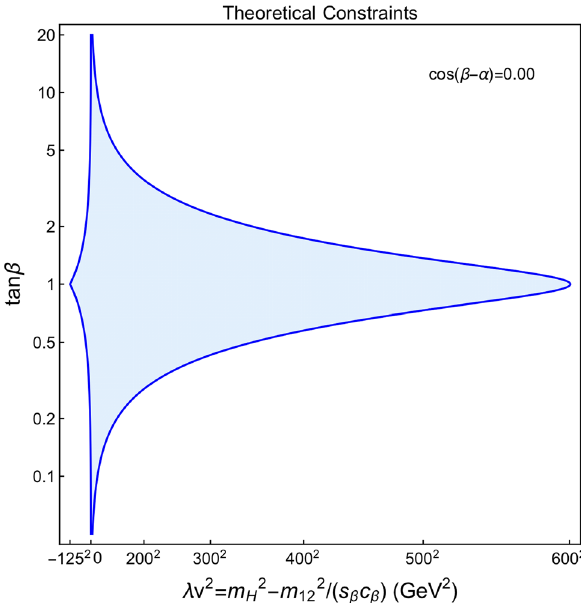
Fig. 1 Allowed regions by and theoretical constraints in the λv 2 -tan β